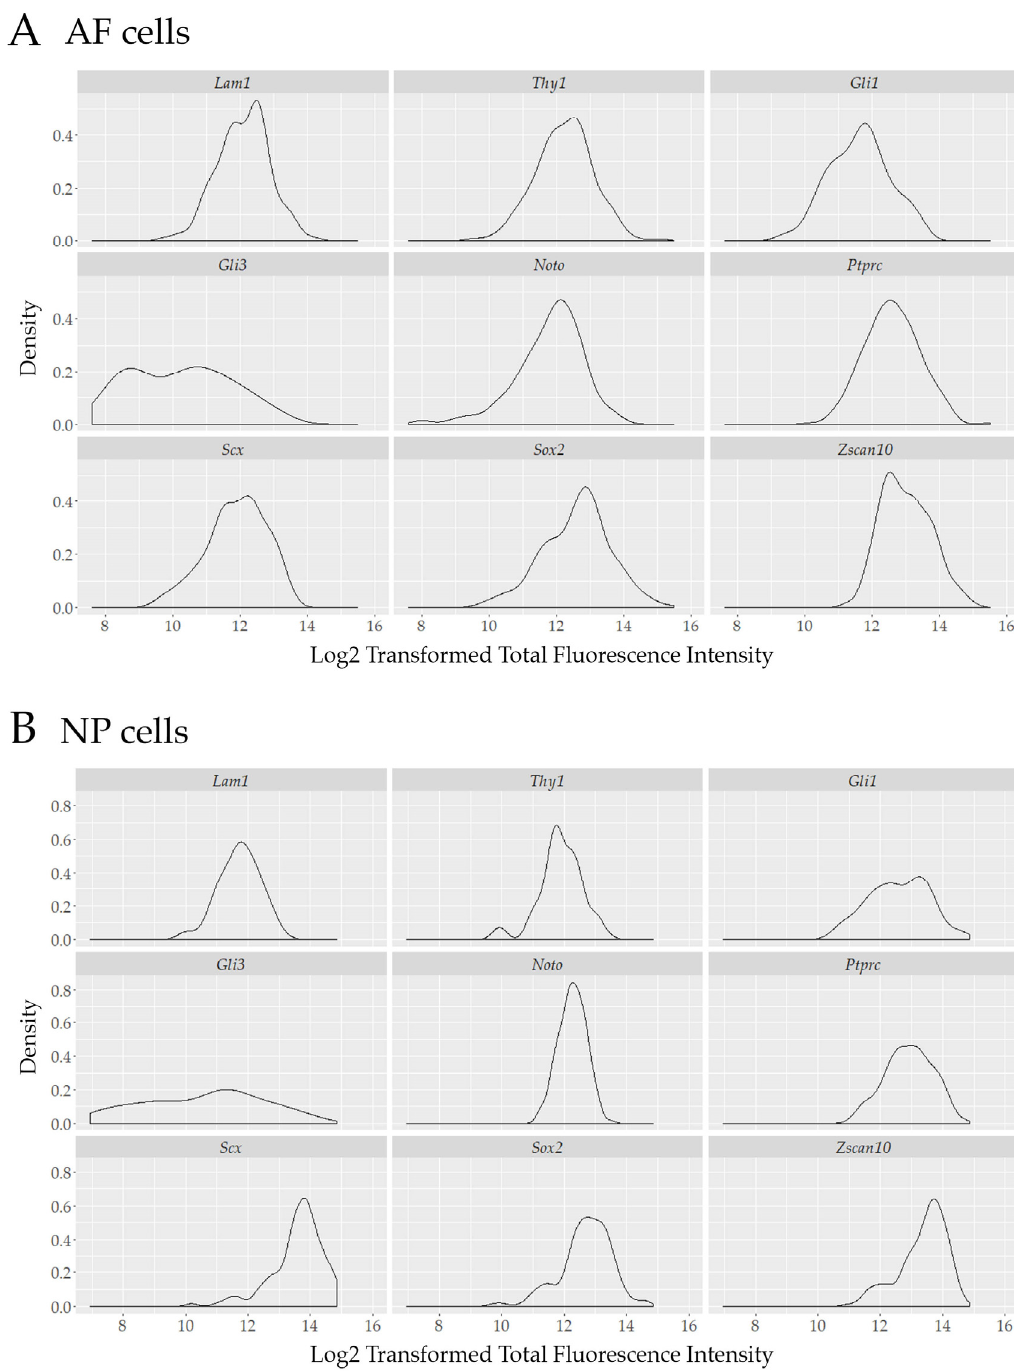
Figure 5. Kernel density estimates for nine proposed biomarkers in ( A ) cells of the outer AF and ( B ) NP of a mature bovine IVD illustrating the potential heterogeneity within the group of transcriptionally active cells. Cell density on the y-axis is plotted against the log2 transformation of the total fluorescence intensity on the x-axis. Laminin1 ( Lam1 ); Thymocyte differentiation antigen 1 ( Thy1 ); Glioma-associated oncogene 1 ( Gli1 ); Glioma-associated oncogene 3 ( Gli3 ); Notochord ( Noto ); Tyrosine phosphate receptor type C ( Ptprc ); Scleraxis ( Scx ); Sex determining region Y-box 2 ( Sox2 ); Zinc finger and SCAN ( SRE-ZBP, CTfin51, AW-1 and Number 18 cDNA) domain containing transcription factor 10 ( Zscan10 ).